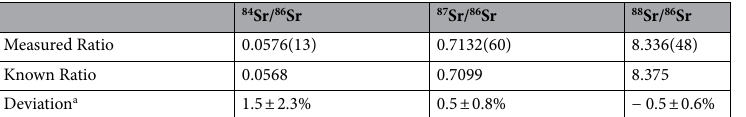
Table 2. Sr isotopic standard measurements. Uncertainties in the isotope ratios are 1σ. (see Supplemental Material for calculation of uncertainty). a Deviation = 100 × (R measured /R known −1).